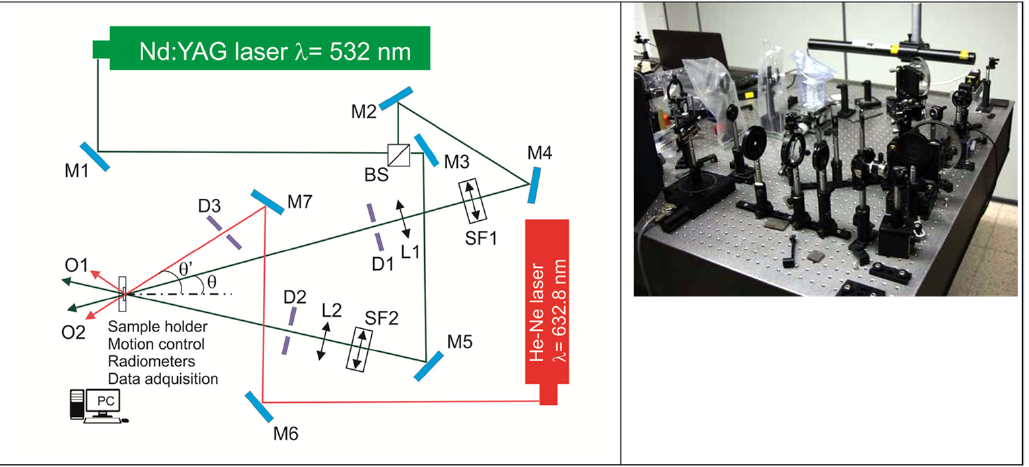
Figure 1. Holographic setup. BS: Beamsplitter, Mi: mirror, SFi: spatial filter, Li: lens, Di: diaphragm, Oi: radiometer, PC: data recorder.